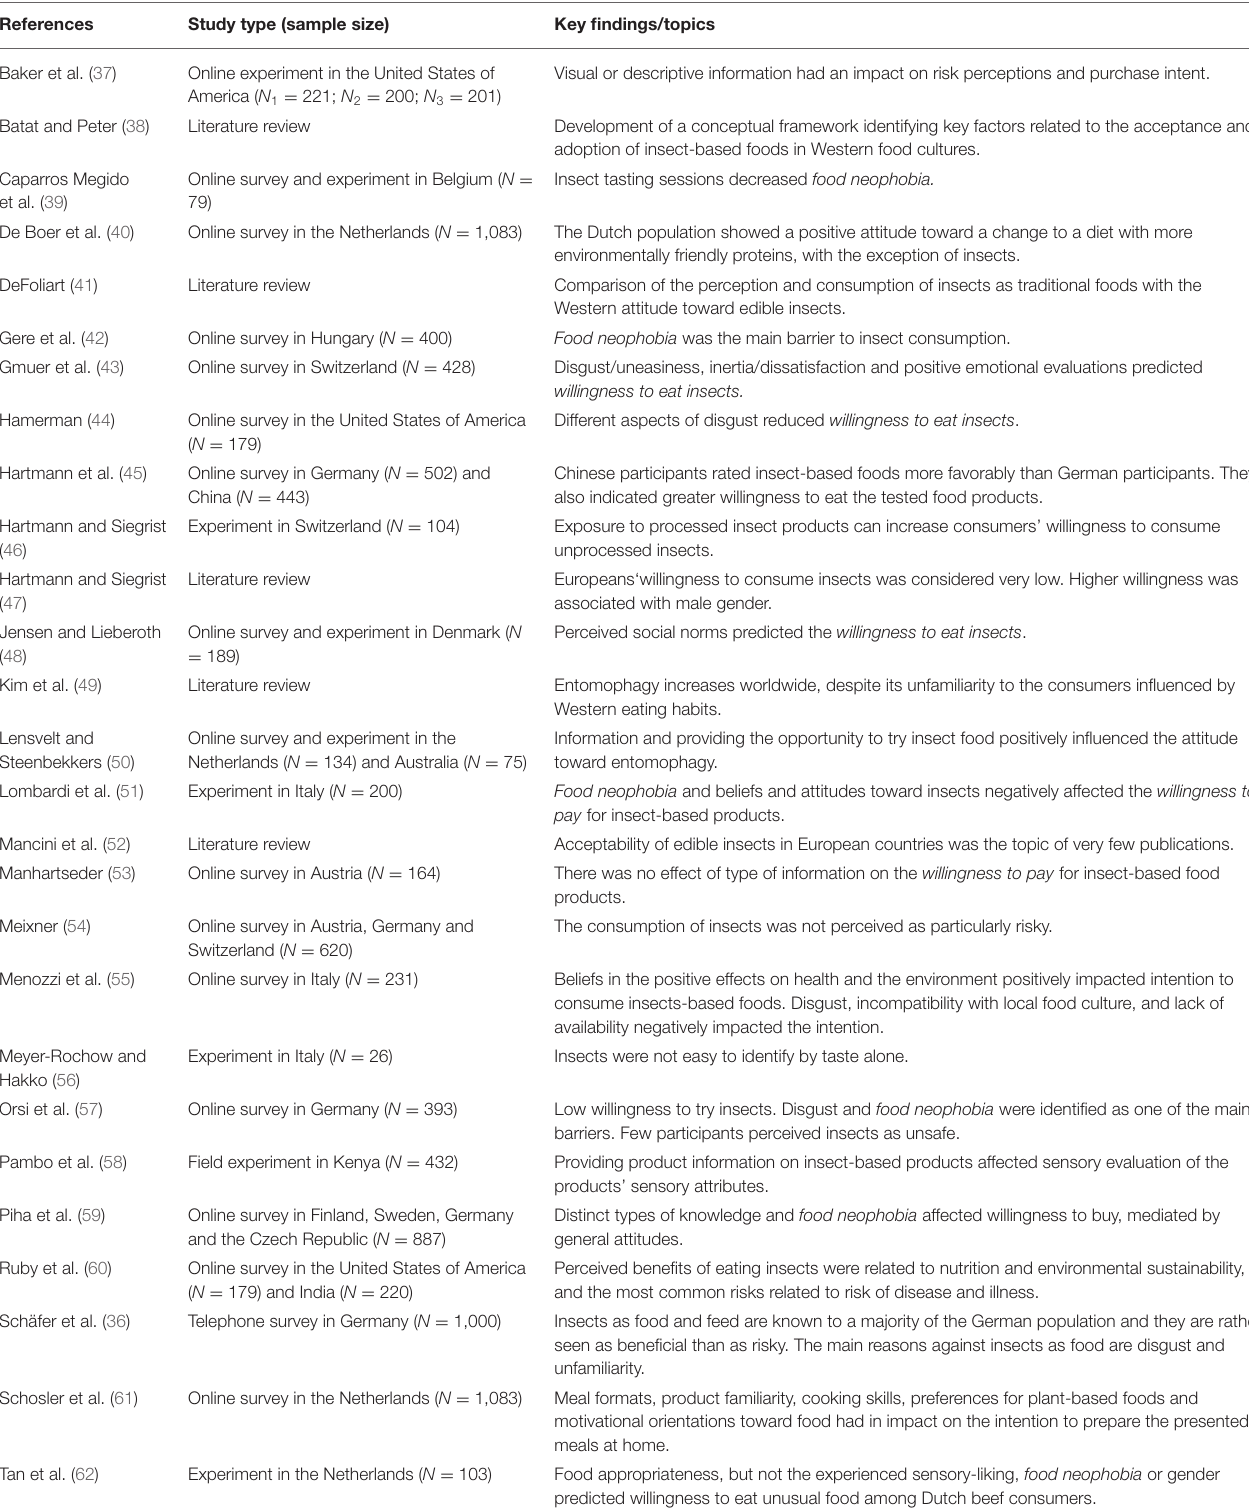
TABLE 1 | Overview of the publications selected as relevant to risk perception relating to edible insects in the literature